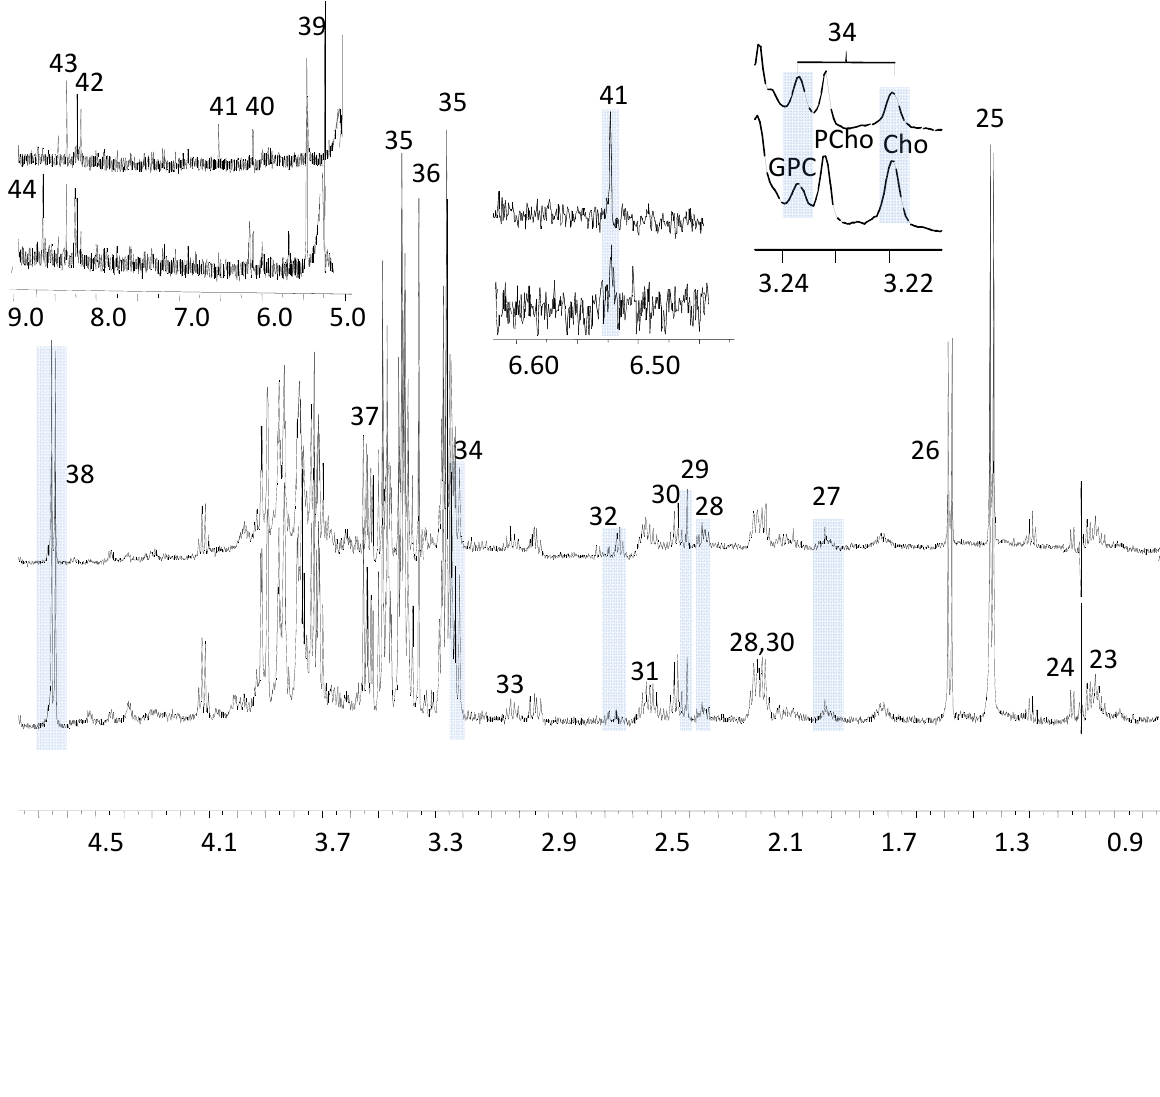
Figure 3. 1 H-NMR Spectra of Selected Hydrophilic Metabolites, Bottom: Control; Top: Tumor. (D O, TSP). Peak assignments are: 23.Leucine; 24.Valine; 2